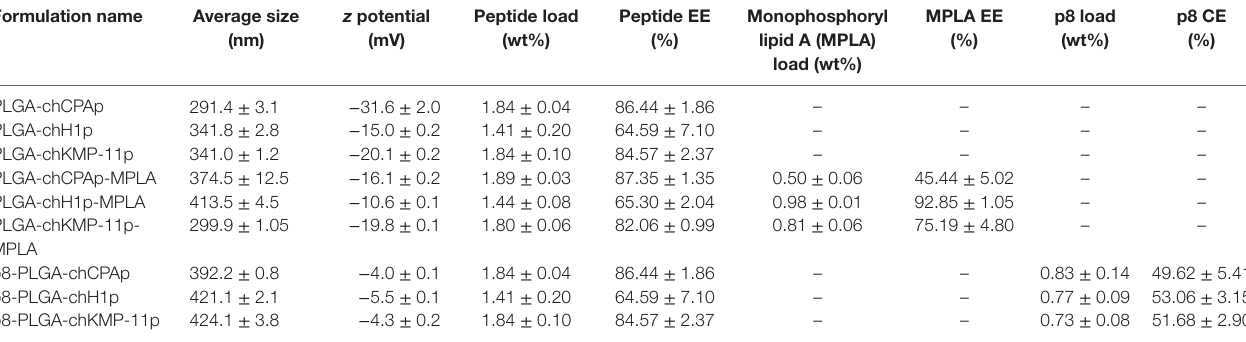
TaBle 3 | Properties of synthesized nanoformulations based on poly(lactic- co -glycolic) acid (PLGA) nanoparticles. Formulation